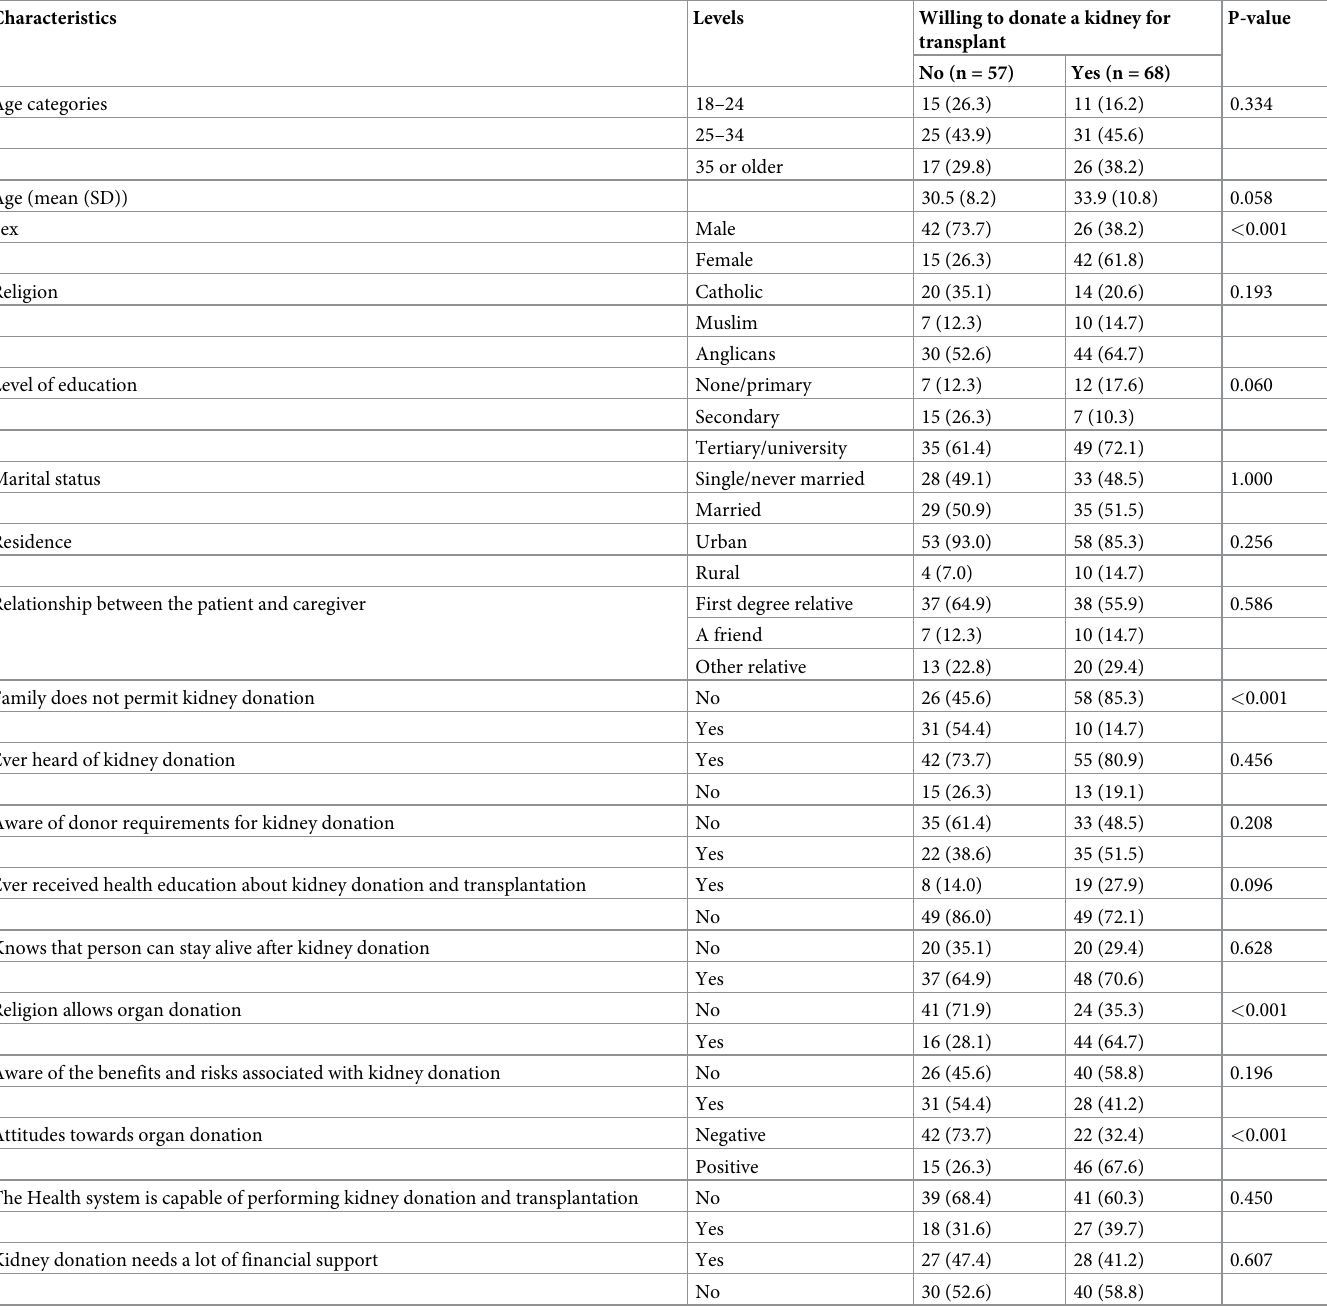
Table 2. Caregivers’ characteristics by the willingness to donate a kidney for patients with ESRD.